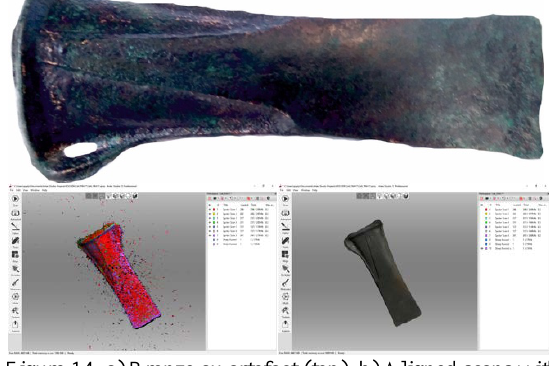
Figure 14. a) Bronze ax artefact (top); b) Aligned scans with the presence of outliers (bottom left); c) 3D Model (bottom